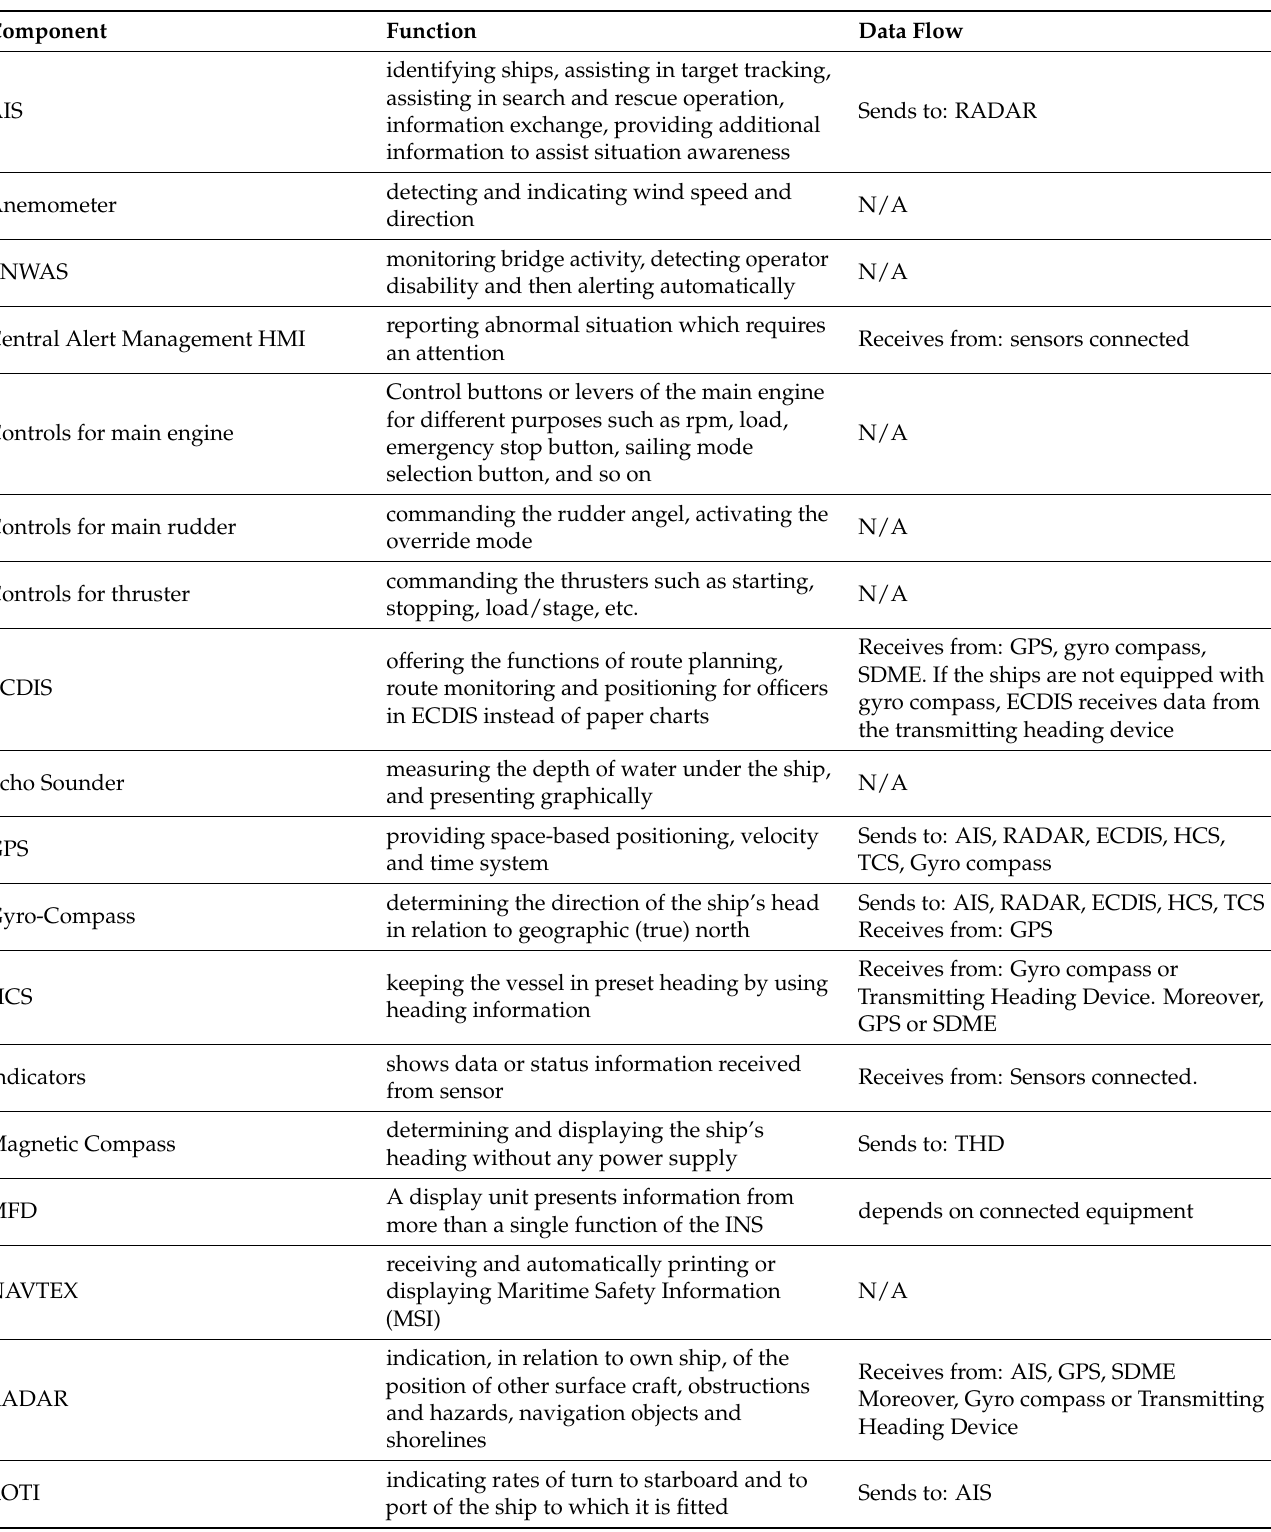
Table 3. Functions of components and data flow